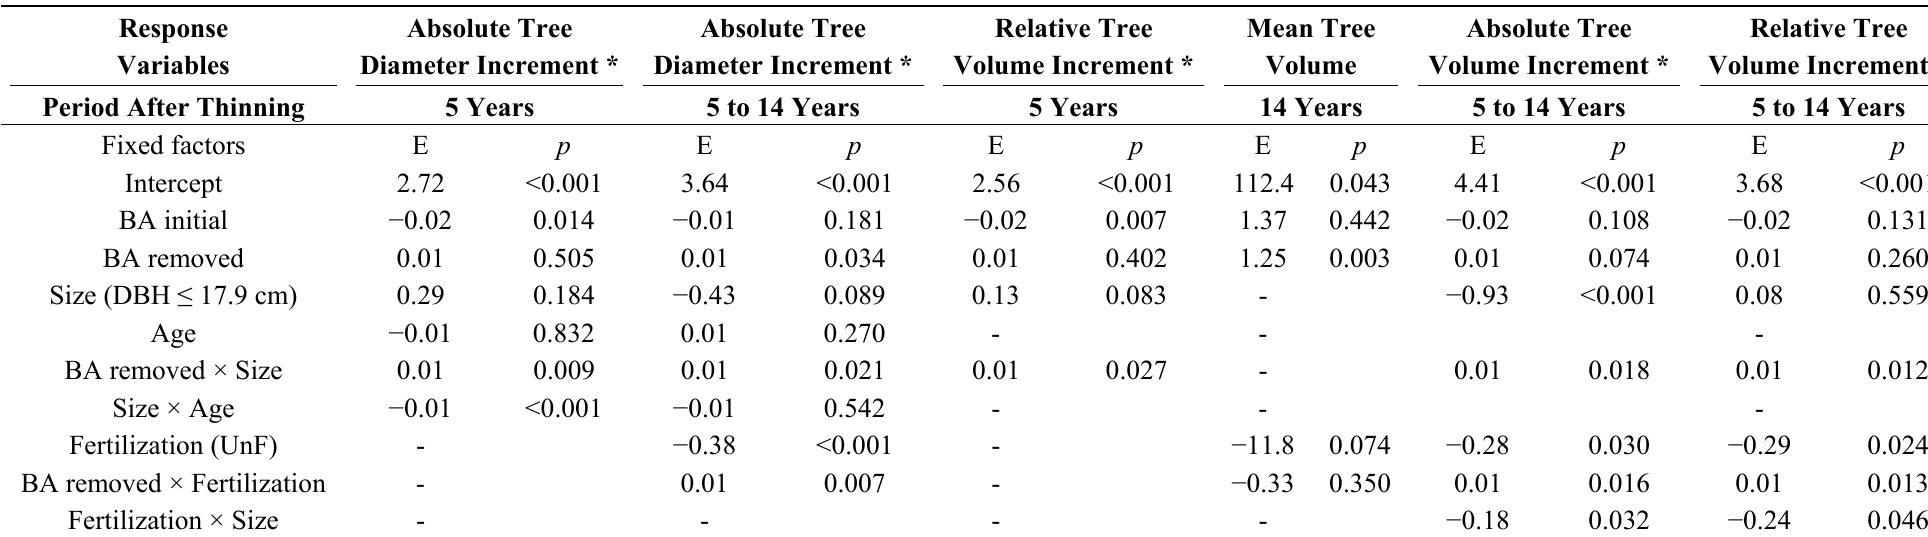
Table 2. Residual tree response to commercial thinning and fertilization of jack pine stands over periods of 5 years and 5 to 14 years following thinning. Fertilization was conducted within sub-plots in each experimental unit 3 to 5 years after thinning. Effects of initial stand basal area and age, basal area removed by thinning, tree size, fertilization and selected interactions assessed by means of mixed linear